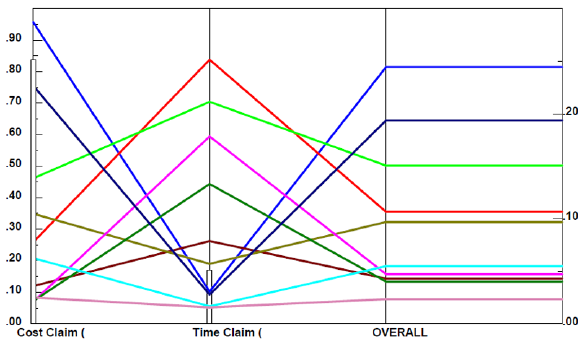
Fig. 1. The graph of sensitivity analysis for the causes of